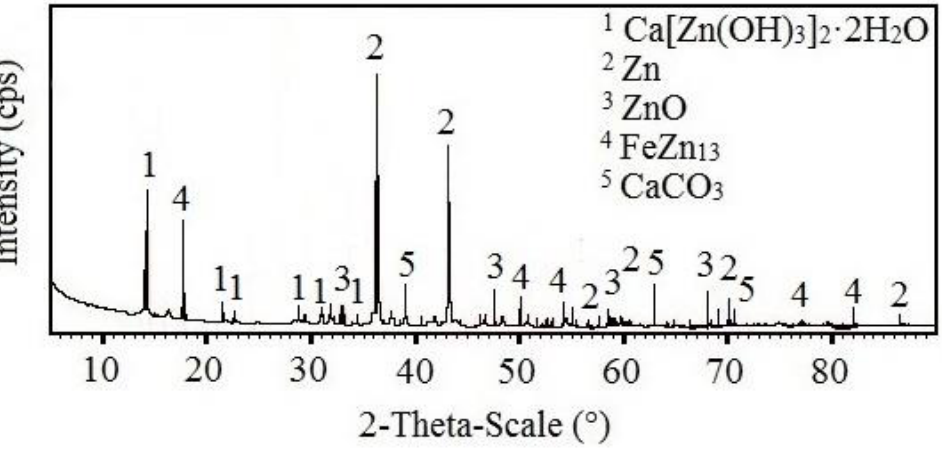
Figure 28. XRD analysis of HDG sample exposed for the duration of 3 months in simulated concrete pore solution of pH 12.8 with addition of MnO 4 − (Mn( 2 )).